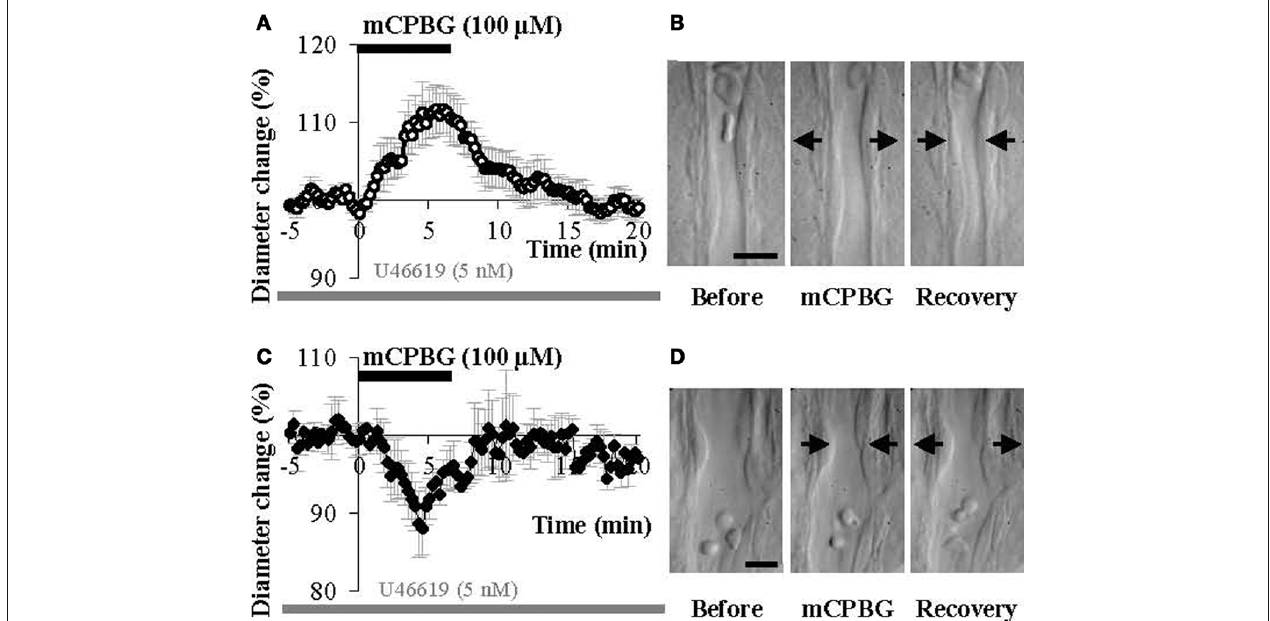
indicate region of high vascular reactivity. (C) Mean vascular constriction ( n = 4) induced by mCPBG (100 μ M). (D) Infrared images of a penetrating